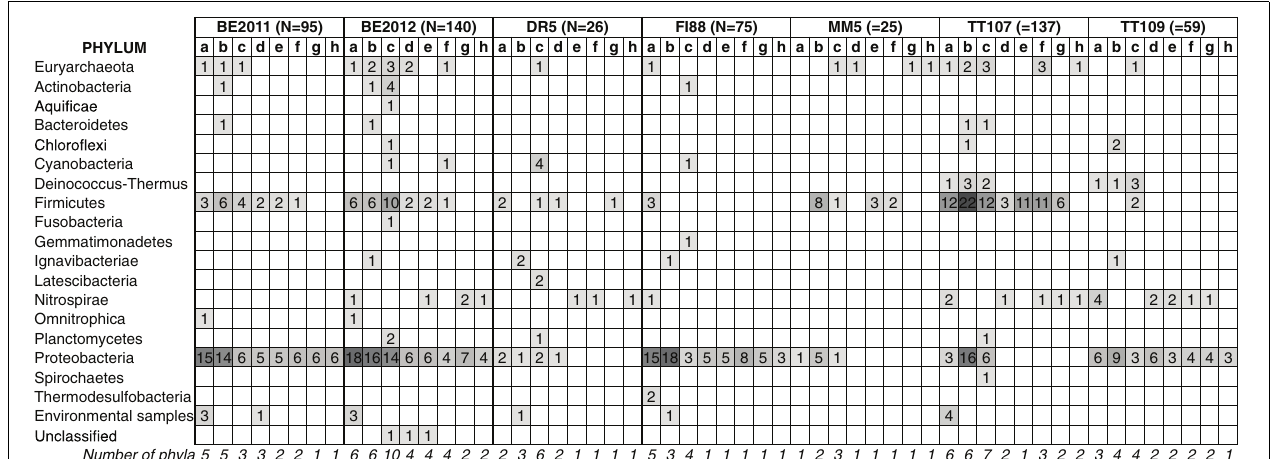
FIGURE 2 | Phylum-level taxonomic distribution of eight common functional genes detected in the subsurface metagenomes. N denotes the total number of gene sequences detected in the metagenomes. The taxonomic classification of these sequences was assigned based on the lineage of their NR-best hit. The common functional genes are denoted